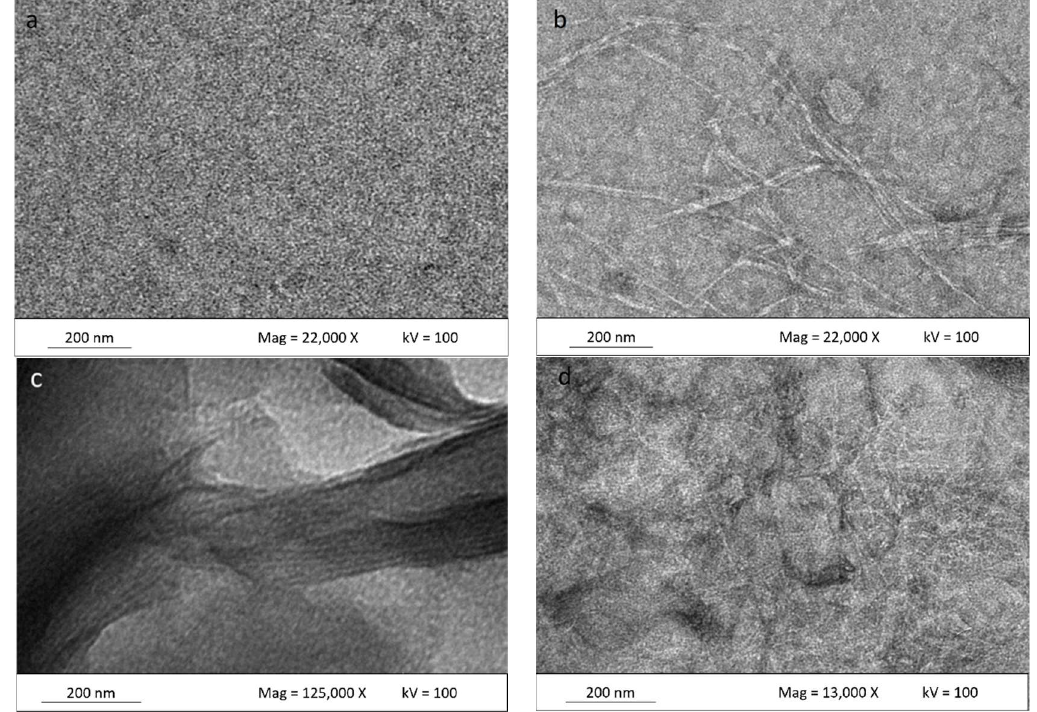
Figure 6. Surface TEM micrographs of ( a ) κ-carr matrix film; ( b ) κ-carr/4% CNC bionanocomposite, ( c ) κ-carr/4% OMMT bionanocomposite, and ( d ) hybrid κ-carr/ 4% (CNC/OMMT) (1:1) bionanocomposite.